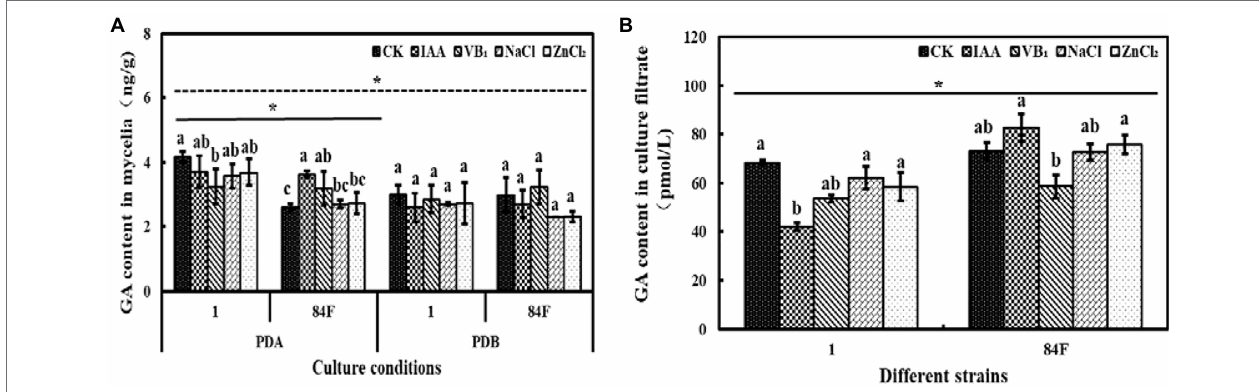
FIGURE 6 | Gibberlic acid content of E. sinensis under different treatments for 4 weeks. (A) is GA content in mycelia, and (B) is GA content in culture filtrate. The same as Figure 1